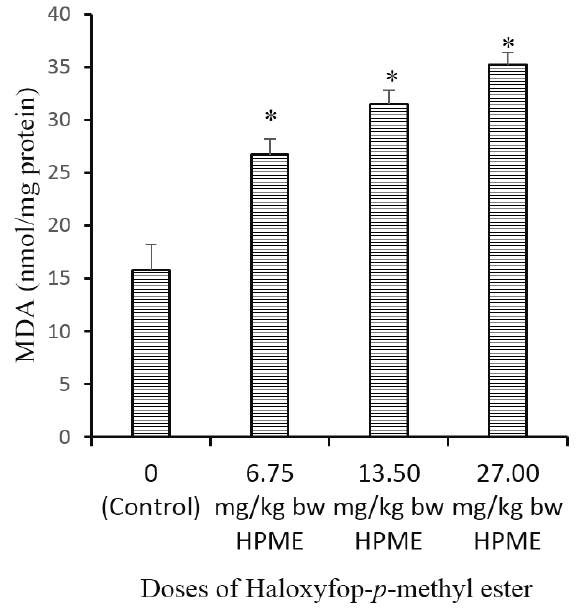
Figure 4. The influence of haloxyfop- p -methyl ester on the levels of malondialdehyde (MDA) in rat testis; data represent the mean of six replicates ± standard deviation. * Significance of difference at p < 0.05 (Duncan’s multiple comparison of control and HPME-treated